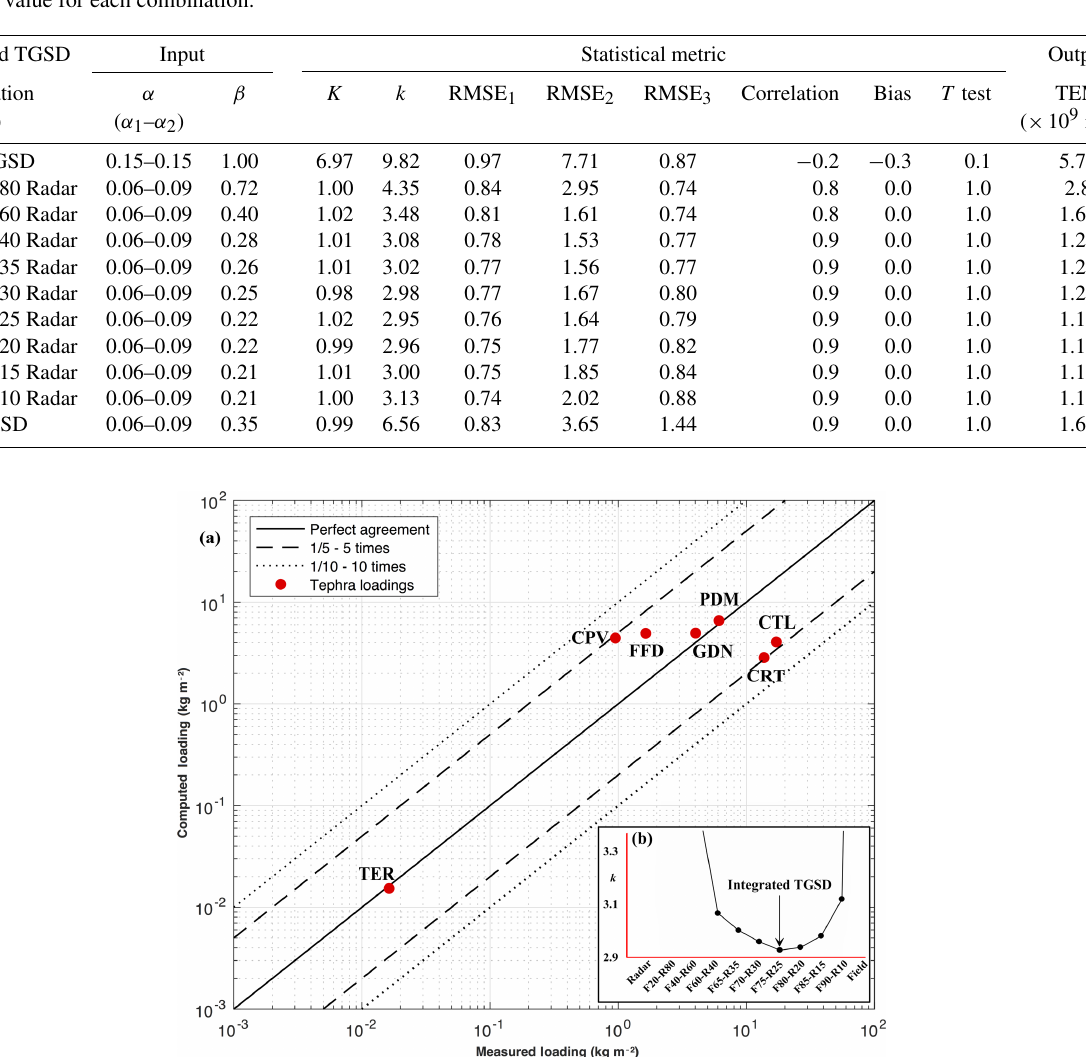
Table 3. Statistical metric for the best simulations (i.e. calibration of α and β ) for each weighting average combination tested during the inversion of the Integrated TGSD. α is described through α 1 and α 2 within the calculation (Folch et al., 2016). TEM indicates the associated theoretical value for each combination.